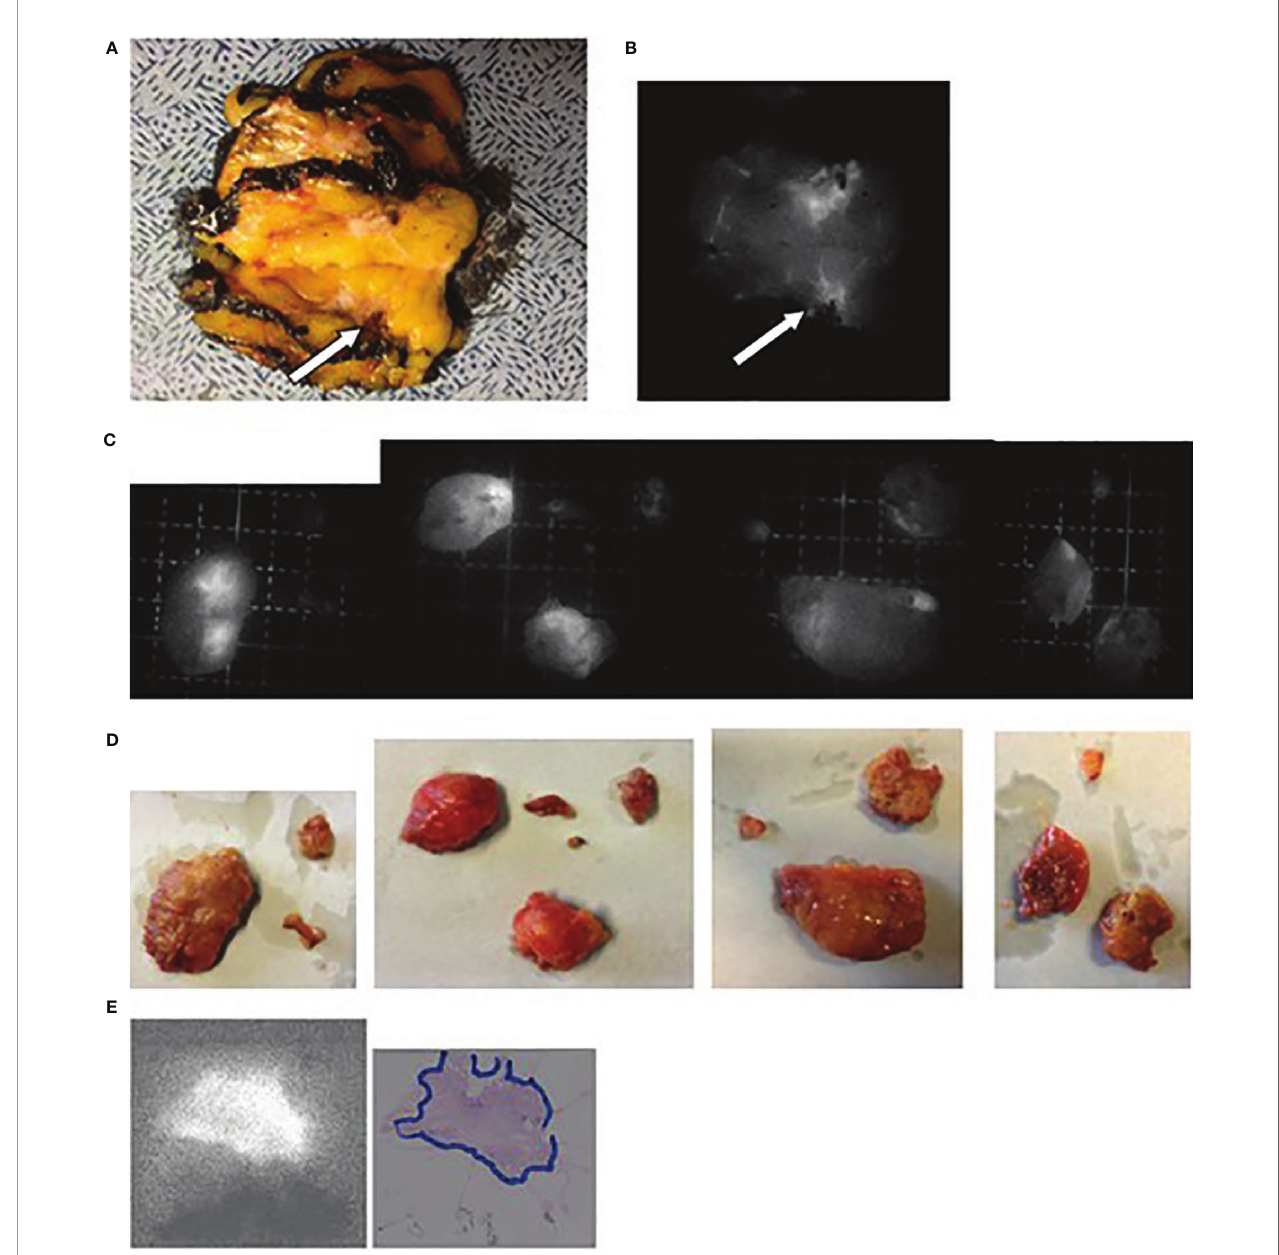
FIGURE 2 | Images obtained for patient N° 8 who underwent a tumorectomy with CALND after neoadjuvant hormone therapy. (A) Lesion (arrow) on the freshly sliced specimen. (B) NIR fl uorescence image of the same slices with the arrow showing the tumor. (C, D) Fluorescent and optical images of the axillary LNs. (E) Fluorescent images of the tumor embedded in paraf fi n and the corresponding H&E-stained pathological slices with delineation of the tumor